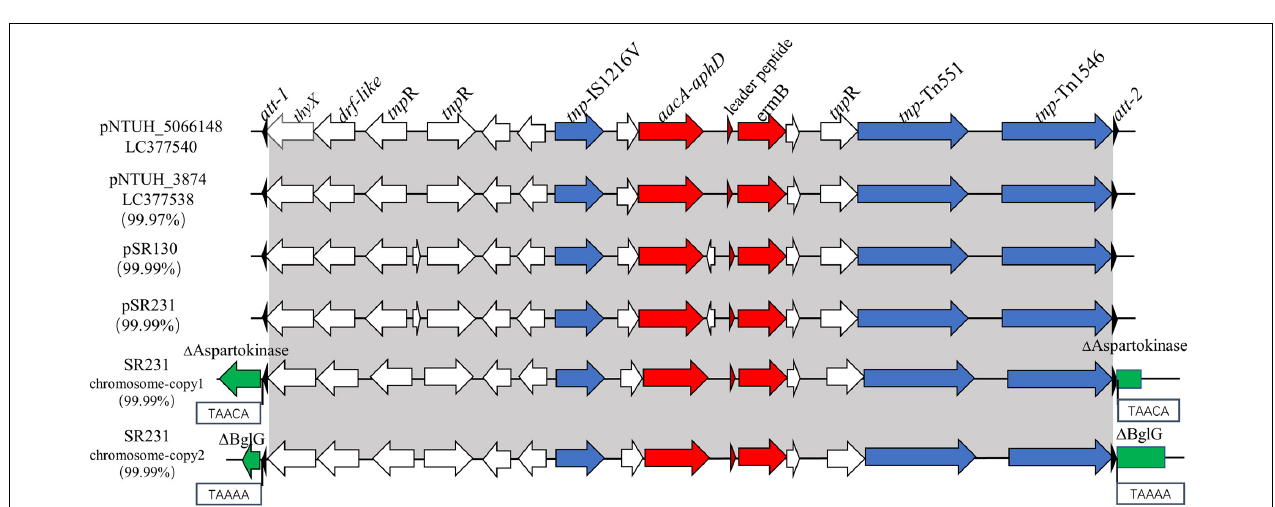
FIGURE 1 | Southern blot analysis of the ermB gene. (A) PFGE for Sma I-digested DNA (left four panels) and Southern blot hybridization for the ermB gene (right three panels). (B) PFGE for S1-digested plasmid DNA (left four panels) and Southern blot hybridization for the ermB gene (right three panels). The bands with red arrows showed positive signals by Southern blot hybridization with the ermB probe. SR144 with ermB carried on the chromosome but not in the plasmid was used as a negative control in S1 and a positive control on the chromosome. Salmonella serotype Braenderup strain H9812 was used as a molecular marker. The results showed that the ermB gene is located in the 33.3–54.7 kb plasmid in SR130 and SR 231, and SR 231 also carried two copies of ermB genes on the chromosome.